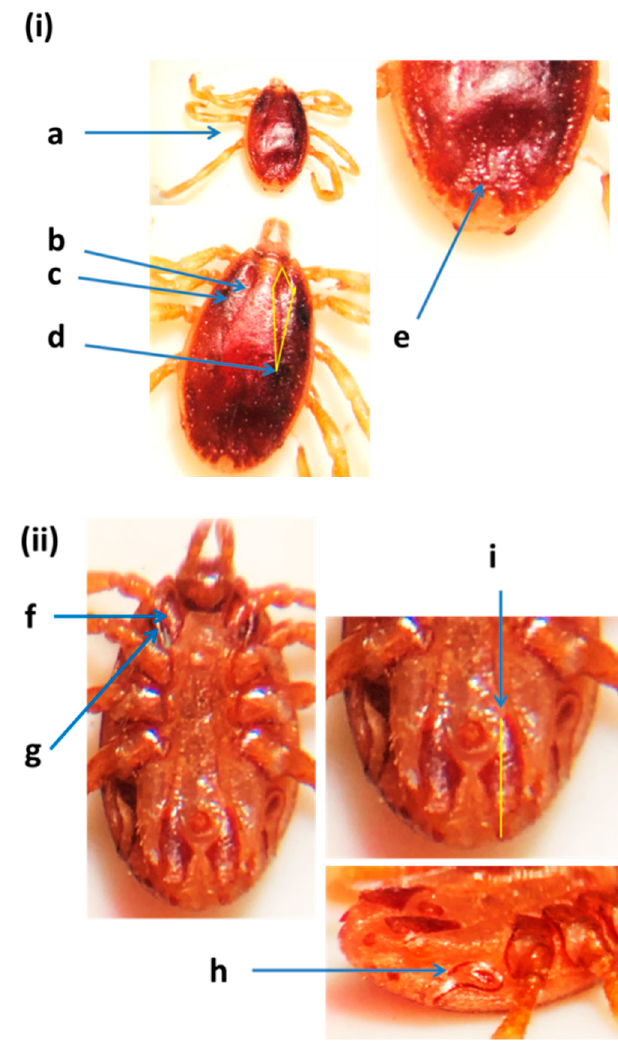
Figure 3. Hyalomma anatolicum male from the United Arab Emirates: ( i ) dorsal view: (a) reddish- brown and oval shape, (b,c) cervical grooves and lateral grooves, (d) cervical and lateral grooves length, (e) posteromedian groove; ( ii ) ventral view: (f) coxae I spurs close together, medial spur in the form of a triangle, (g) coxae I lateral spur (narrow), (h) spiracle plate, (i) subanal shields situated on the axis of the adanals [11,31].